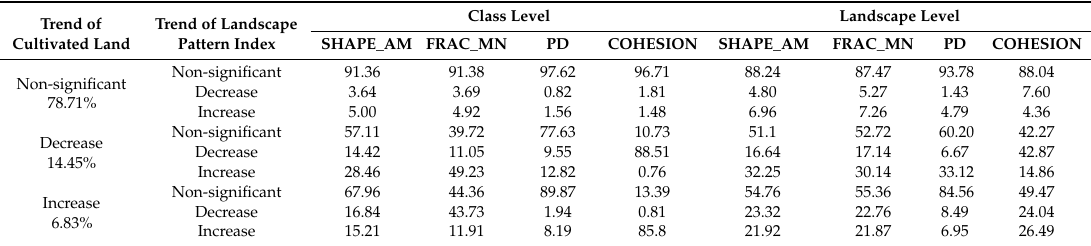
Table 4. Correlation of landscape pattern index between class and landscape level